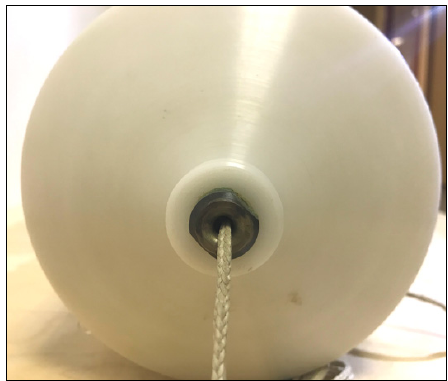
Figure 4. Back view of the profiler wet compartment that houses the winch. The winch wire passes through hawsehole of the wet compartment.